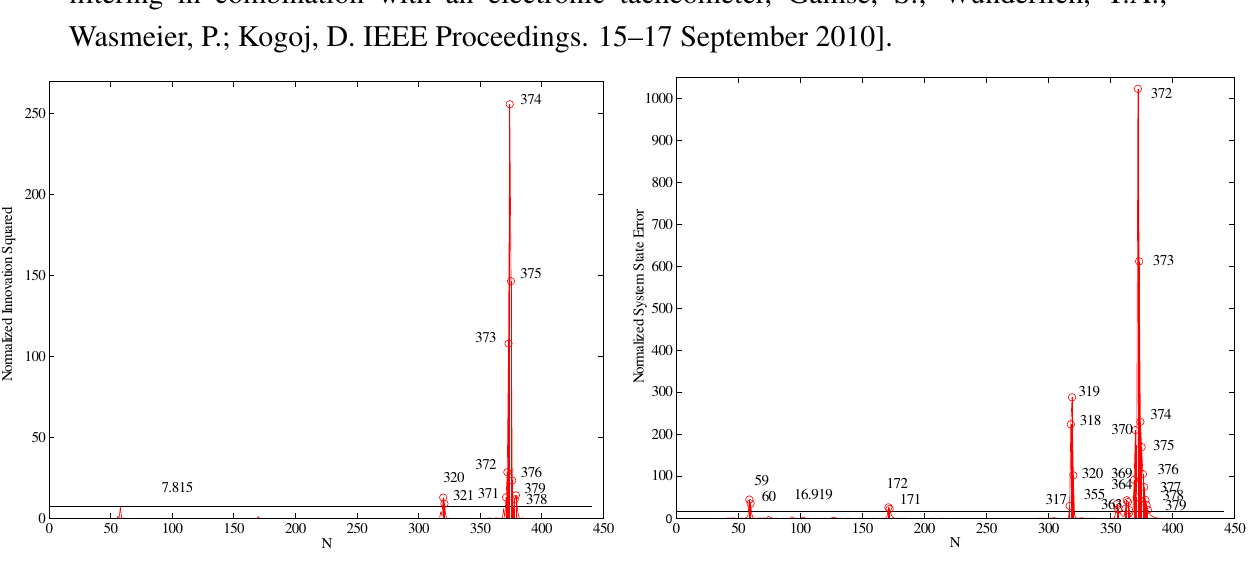
Normalized innovation squared ( Left ) and normalized system state error squared ( Right ), [10]. c (cid:13) [2014] IEEE. Reprinted, with permission, from [The use of Kalman filtering in combination with an electronic tacheometer, Gamse, S.; Wunderlich,